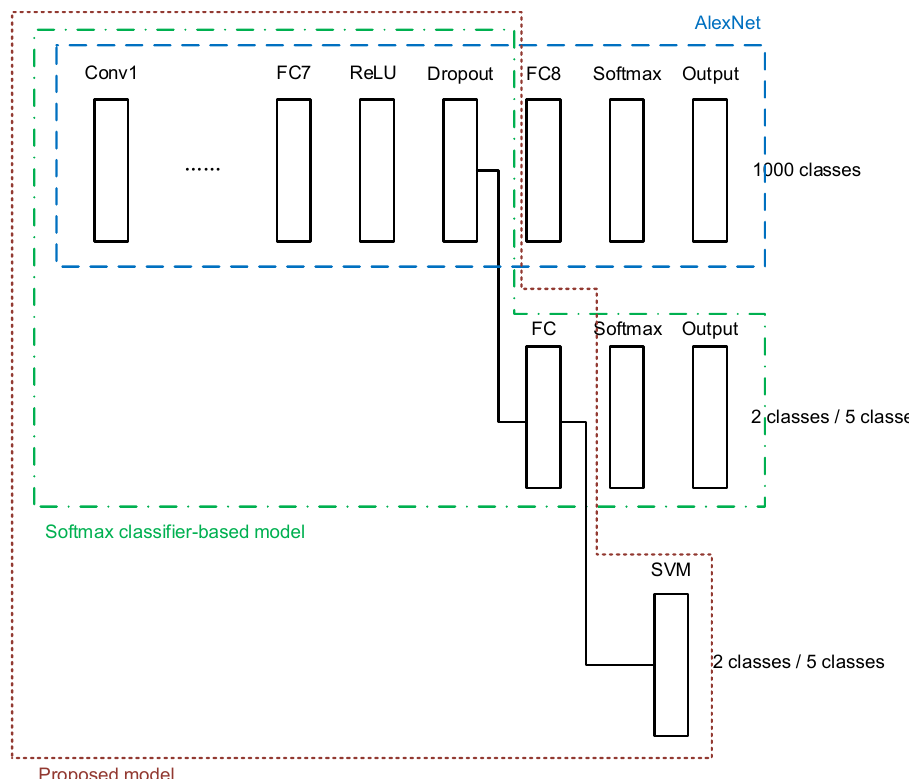
Figure 6. The proposed transfer learning model for histopathology image classification.